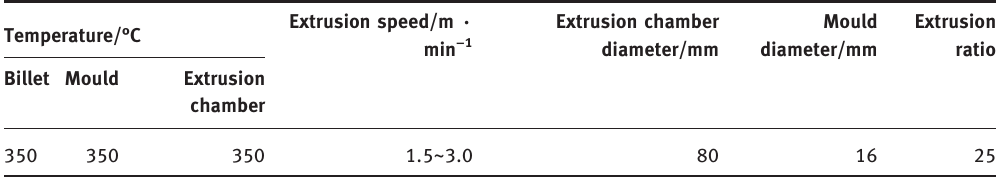
Table 2: Extrusion parameters of the studied alloys.